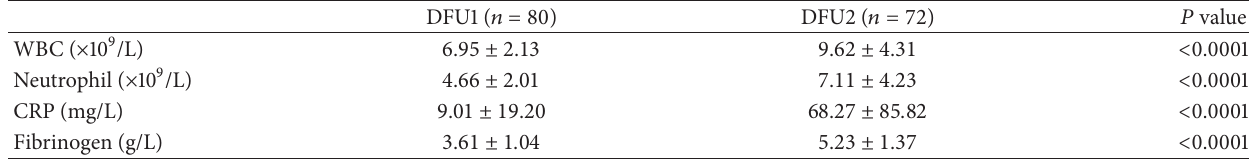
Table 2: Comparison of fibrinogen and other inflammation markers between patients with DFU (grades 1-2) and DFU (grade ≧ 3).